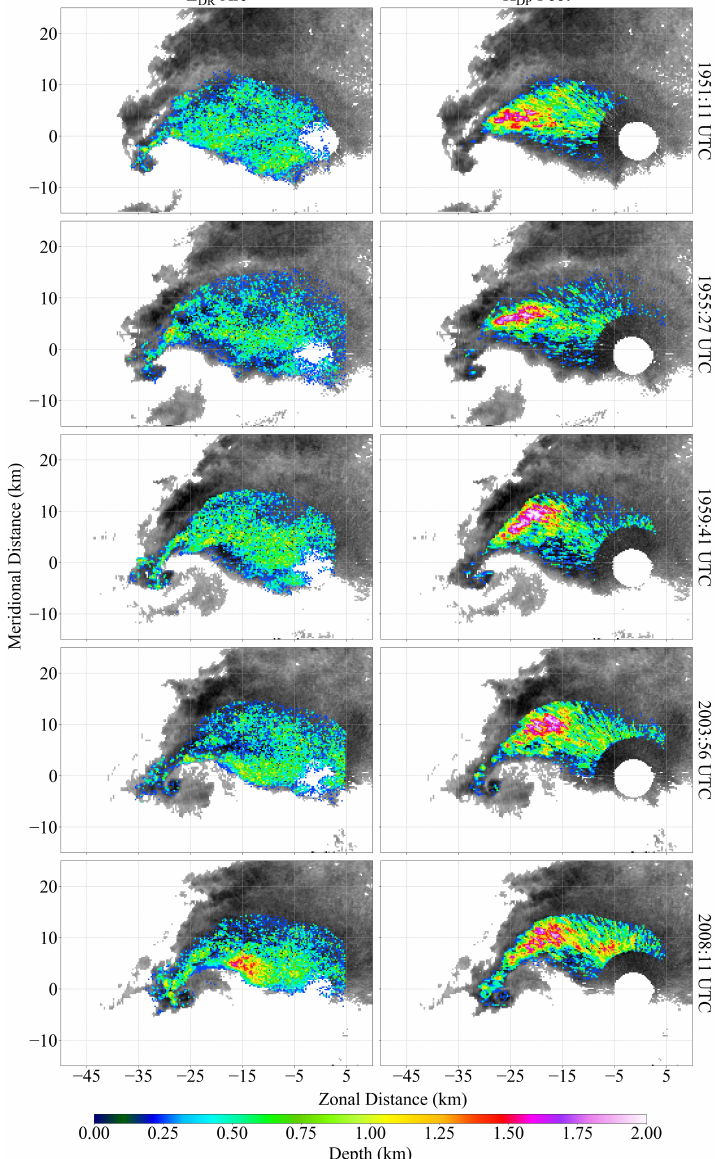
Figure 14. As in Figure 12, except for scans from 1951:11 to 2008:11 UTC (second